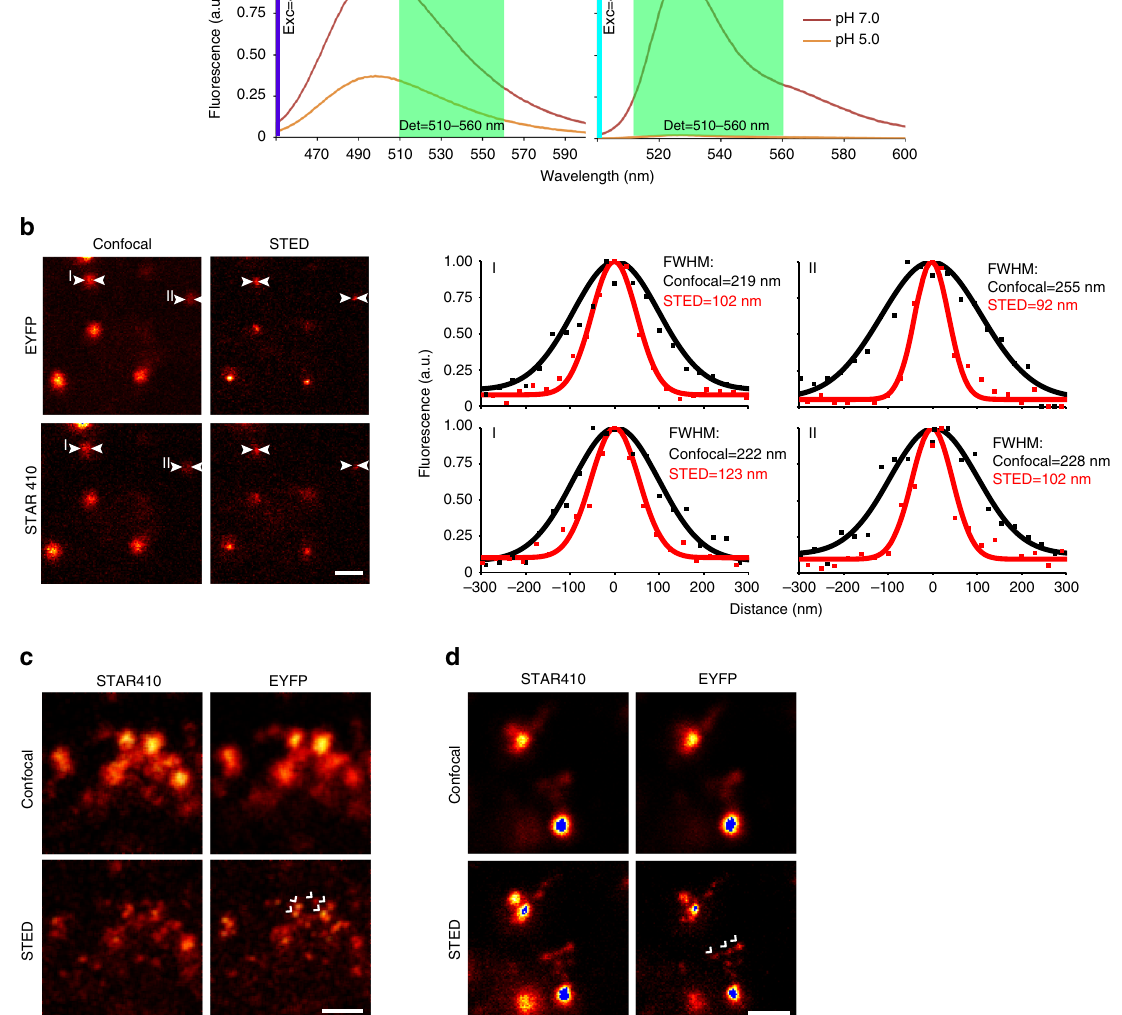
Fig. 3 SRpHi is a super-resolution compatible biosensor. a Relative fl uorescence of STAR410 and TAT-EYFP at pH 7.0 and 5.0 is determined by fl uorescence spectroscopy. The detection range of our custom-built microscope is indicated by light green shading . STAR410 and EYFP were excited by 405 and 490 nm light, respectively. b MEF cells were pulsed with SRpHi1 for 10 min and imaged in PBS using a custom-built STED microscope. Full width at half maximum (FWHM) calculations are presented for two individual endosomes imaged in both confocal and STED mode. c CV-1 cells were loaded with SRpHi1 for 10 min, washed, and imaged. Clusters of endosomes smaller than the diffraction limit c and tubule-like structures protruding from early endosomes d were imaged. Structures only visible by STED are highlighted by white arrows . Blue pixels in d represent saturation. Saturation of these pixels was required to be able to see the much dimmer tubule-like structures. Scale bars : 600 nm b , 250 nm c , The SRpHi probes enable sub-diffraction live-cell imaging of pH changes within endosomes and their associated structures. somes analyzed at pH 5 to obtain the standard curve displayed in Fig. 4b. Compared to 30 randomly chosen ROIs across all of these images, the average signal within the endosomes is ~9-fold larger (average pixel intensities equal to 161 and 18, respectively). In fact, of the nearly 200 endosomes analyzed only one had an average intensity (38) lower than the highest average intensity found in a background ROI (41). Importantly, the variance of the